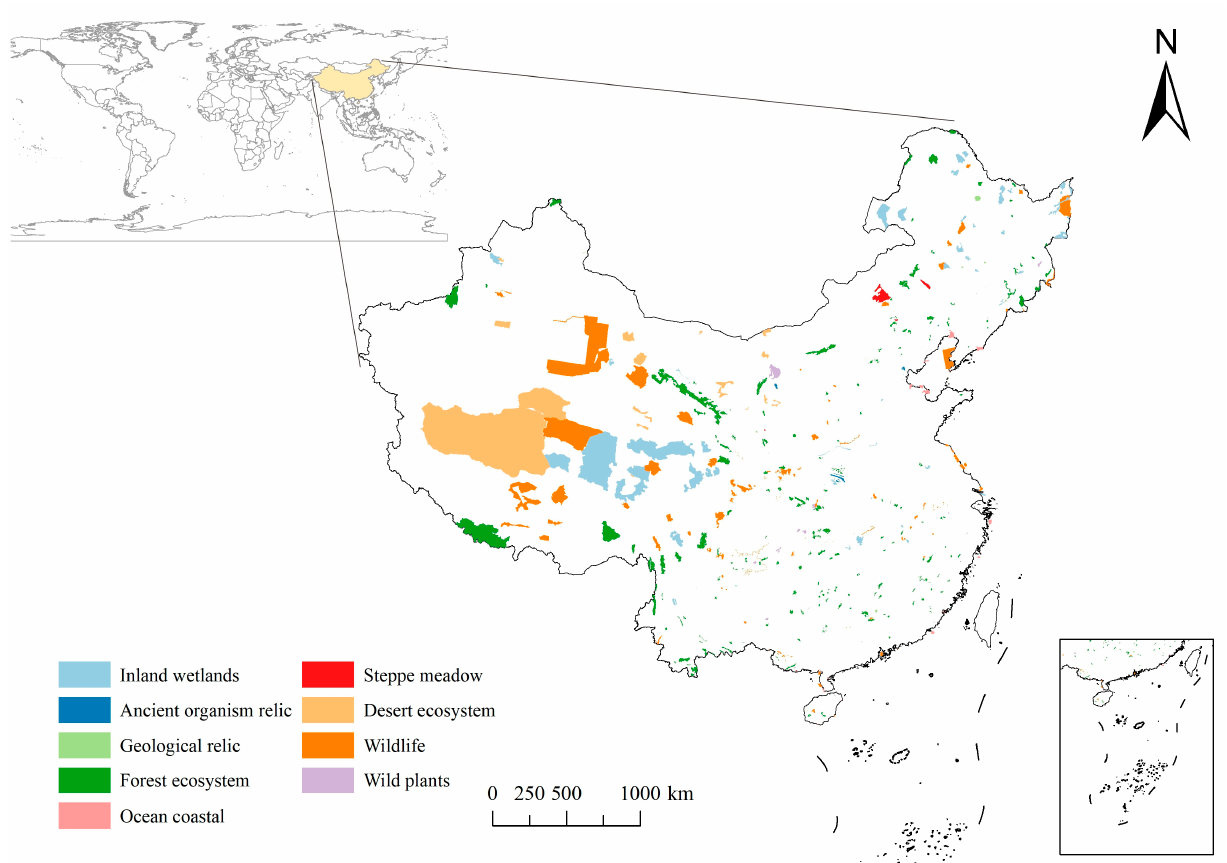
Figure 1. Distribution of National Nature Reserves in China.